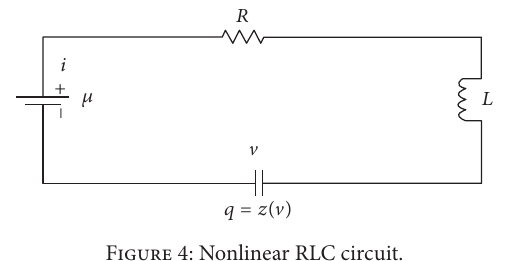
Figure 4: Nonlinear RLC